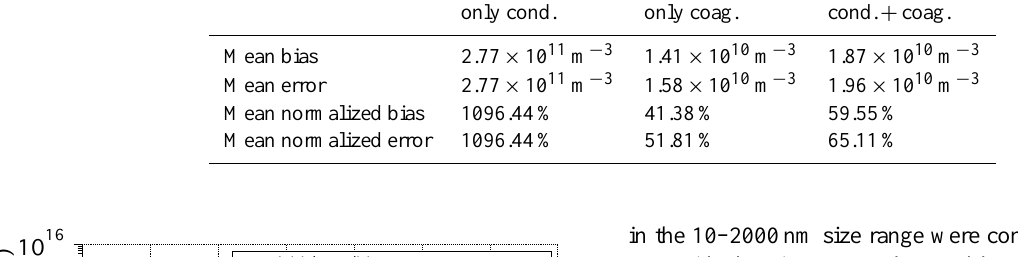
Table 4. Error metrics for comparison of measured and simulated aerosol number concentrations. The “only cond.”, “only coag.” and “cond. + coag.” entries correspond to simulated number concentrations. only cond. only coag. cond. + coag.